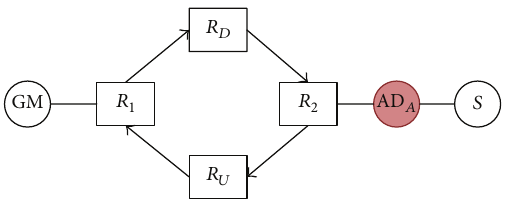
Figure 3: The network topology used for the simulations. Figure 4: Scenario 𝐴 for the network, AD 𝐴 —an adversary.